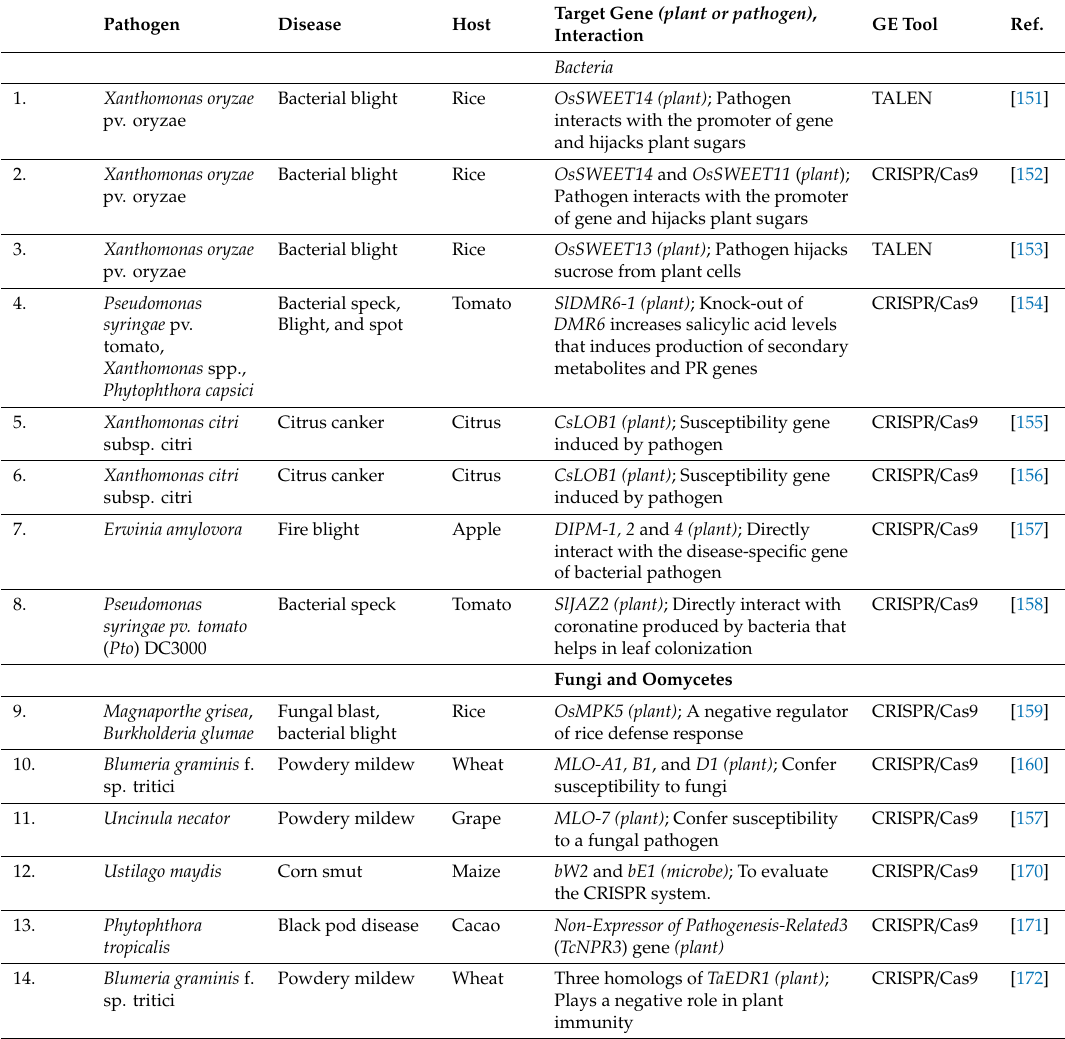
Table 2. List of genome-edited plant–pathogen interactions is